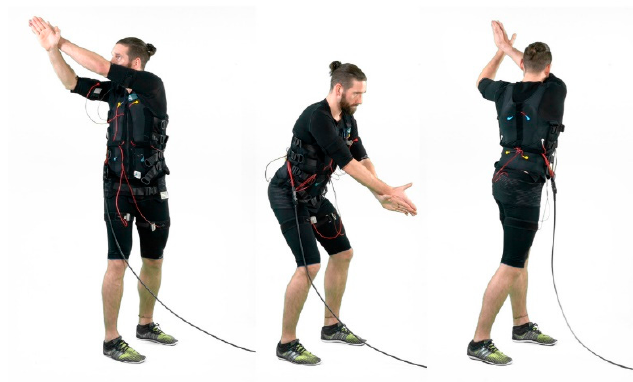
Figure 2. Golf-specific movement during the impulse phase (example). In this context, we focused more on range of motion; thus, we did not instruct participants to consistently watch the ball. Written informed consent was obtained from the participant to publish this